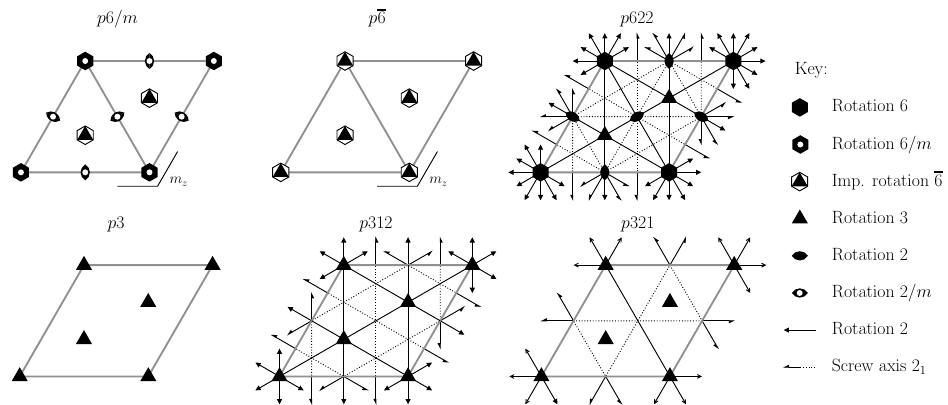
Figure 9: The graphene and hBN moiré bilayers belong to one of these layer groups (adapted from [ 56 ] ). The trivial group p 1 is not